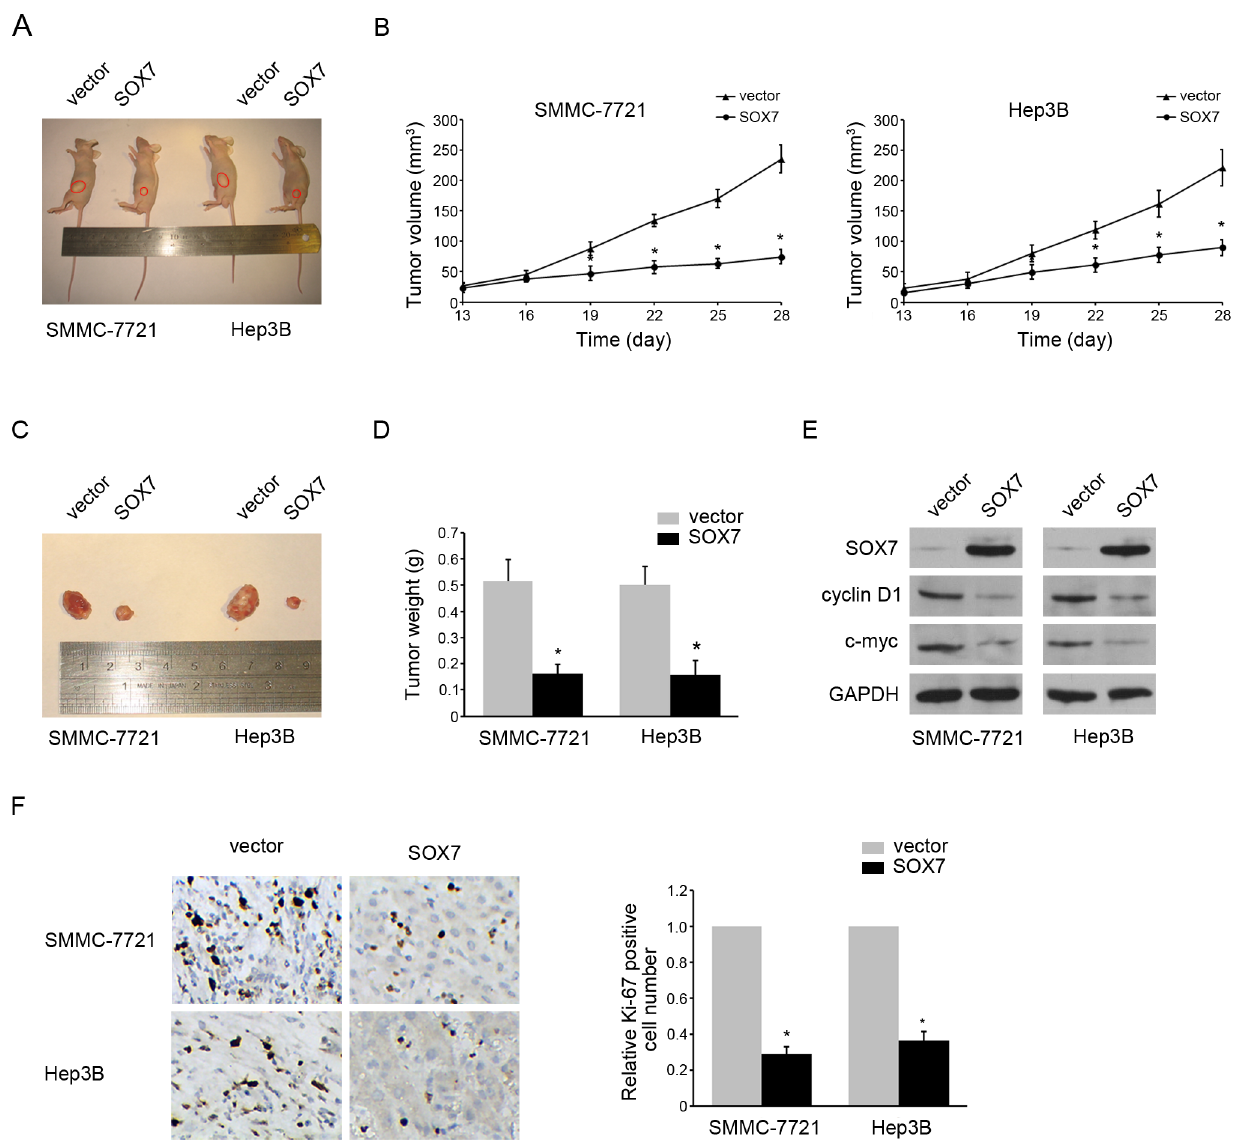
Figure 5. Overexpression of SOX7 suppressed tumor formation. (A) A representative picture of tumor growth in nude mice subcutaneously inoculated with vector or SOX7 transfected HCC cells. The tumors were outlined by red circle. (B) Subcutaneous tumor growth curve of nude mice with different treatment. (C) A representative picture of the isolated tumors. (D) The mean tumor weights in nude mice with different treatment. (E) Western blotting analysis of SOX7, cyclin D1, c-myc and GAPDH levels in the subcutaneous tumor samples. (F) Representative pictures (left panel) and quantification (right panel) of immunohistochemistry-detected Ki-67 expression in the subcutaneous tumor samples. The data were means 6 SD of three separate experiments. * indicates p ,